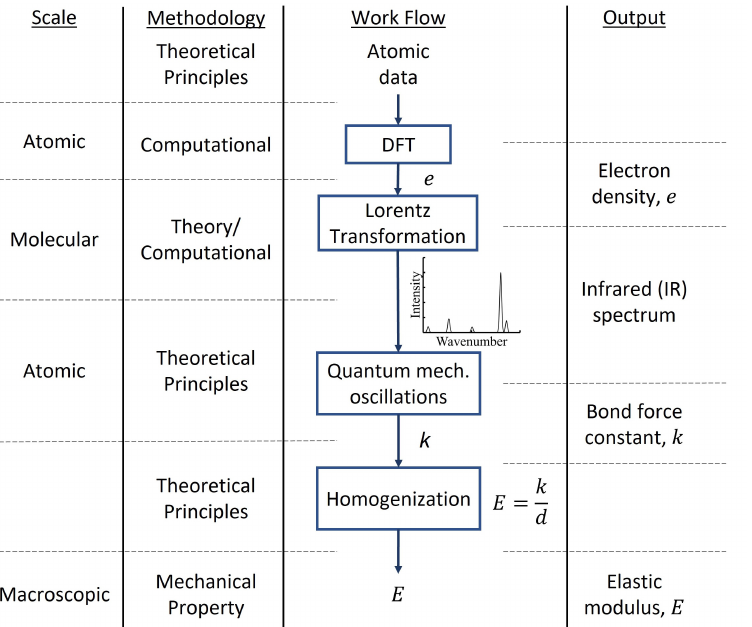
Figure 1. Workflow diagram illustrating the integration between computational methodologies, the scales of their application, and the output from each